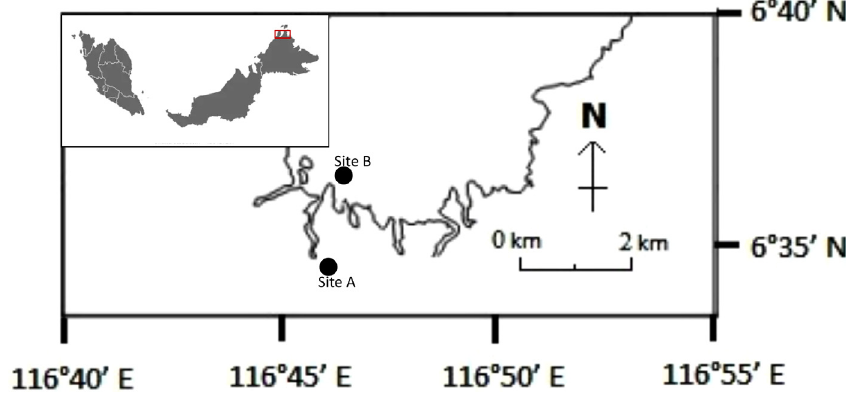
Fig. 1. Location of the sampling stations for harvesting the hard clam, Meretrix meretrix in Marudu Bay, Malaysia.